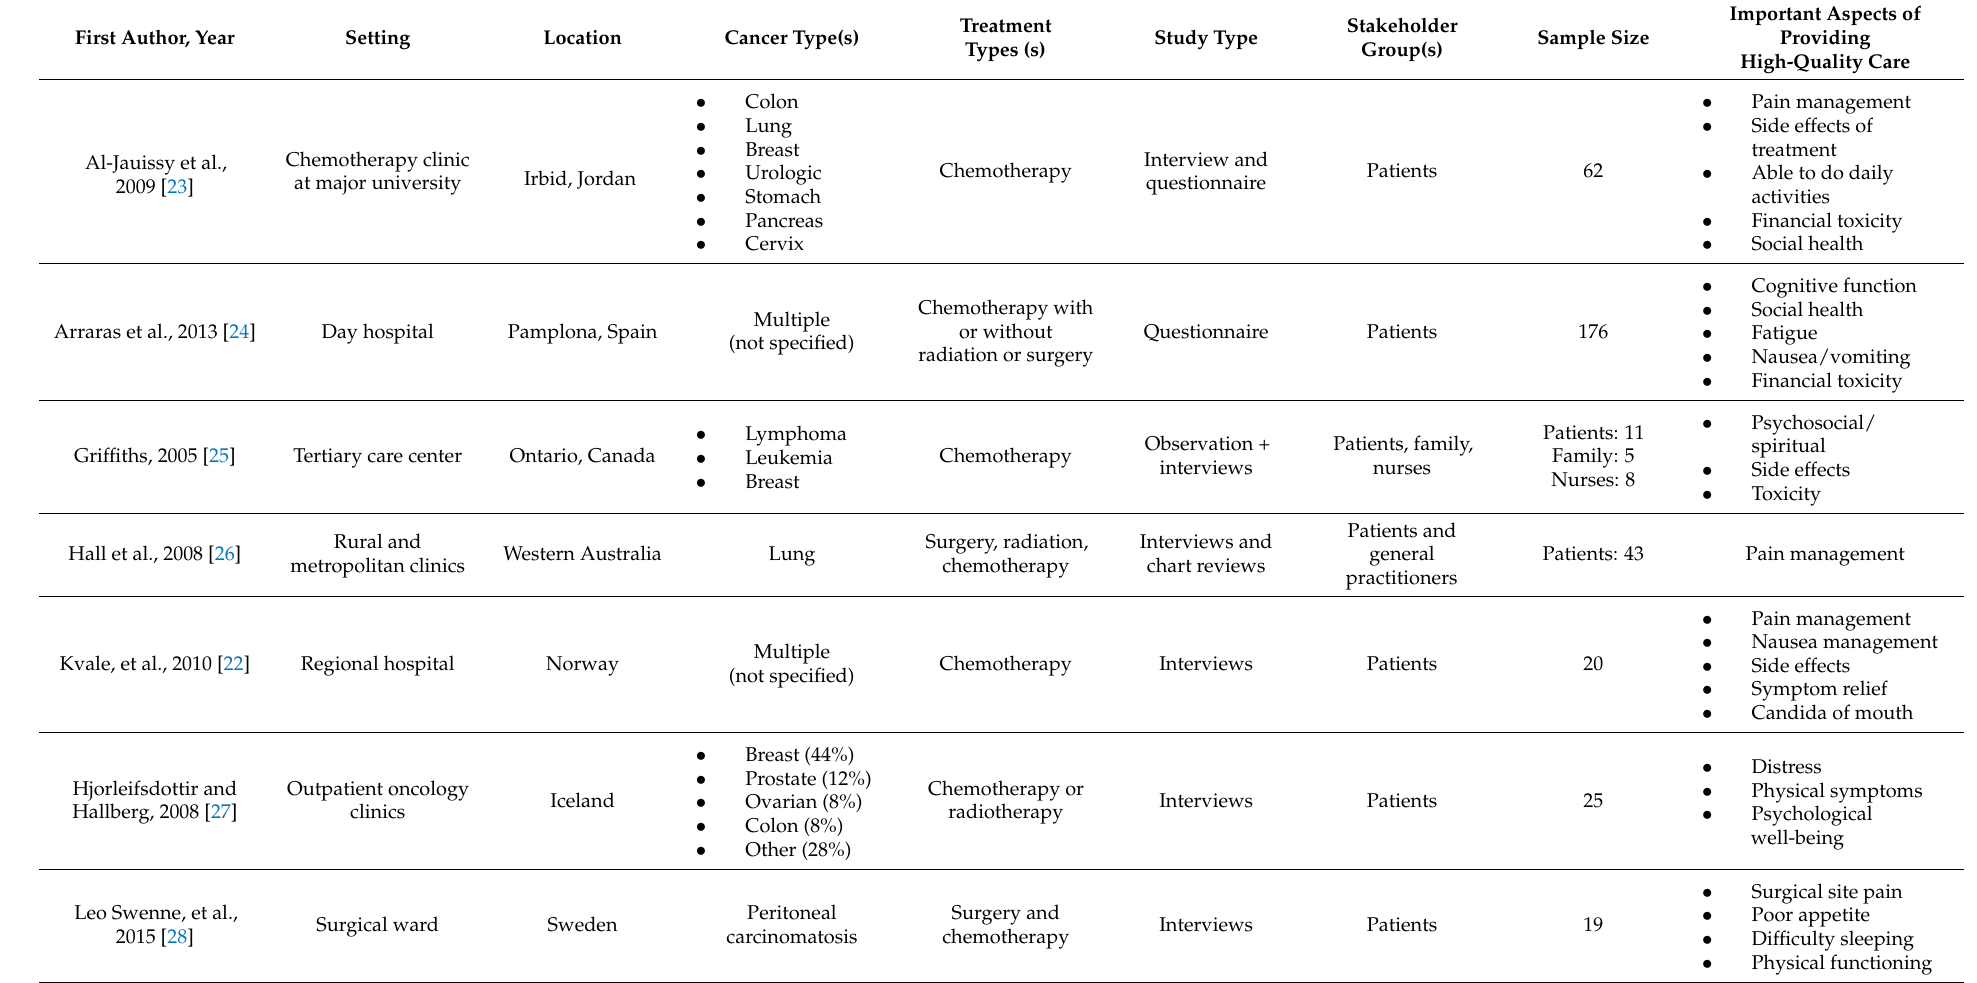
Table 2. Studies conducted outside of the US ( n =